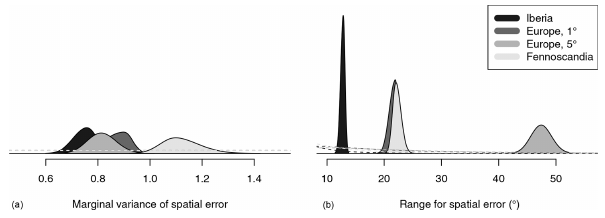
Figure 7. Posterior distributions of the marginal variance ( a ; Eq. 5) and the range parameter ( b ; Eq. 6) for the spatially structured error term for all four data sets. Prior distributions for each data set are indicated with dashed lines.